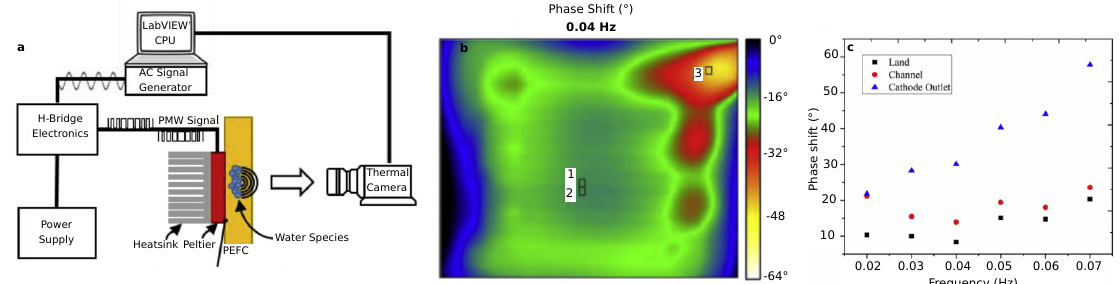
Figure 6. Lock-in thermography technique: ( a ) Schematic of the setup to peform Lock-in thermography on open cathode PEMFC, ( b ) spatially distributed phase shift of Z LIT at the frequency of 0.04 Hz, and ( c ) phase shift Bode plots at different positions in the cell. Figures adapted from [14] with permission from Elsevier.